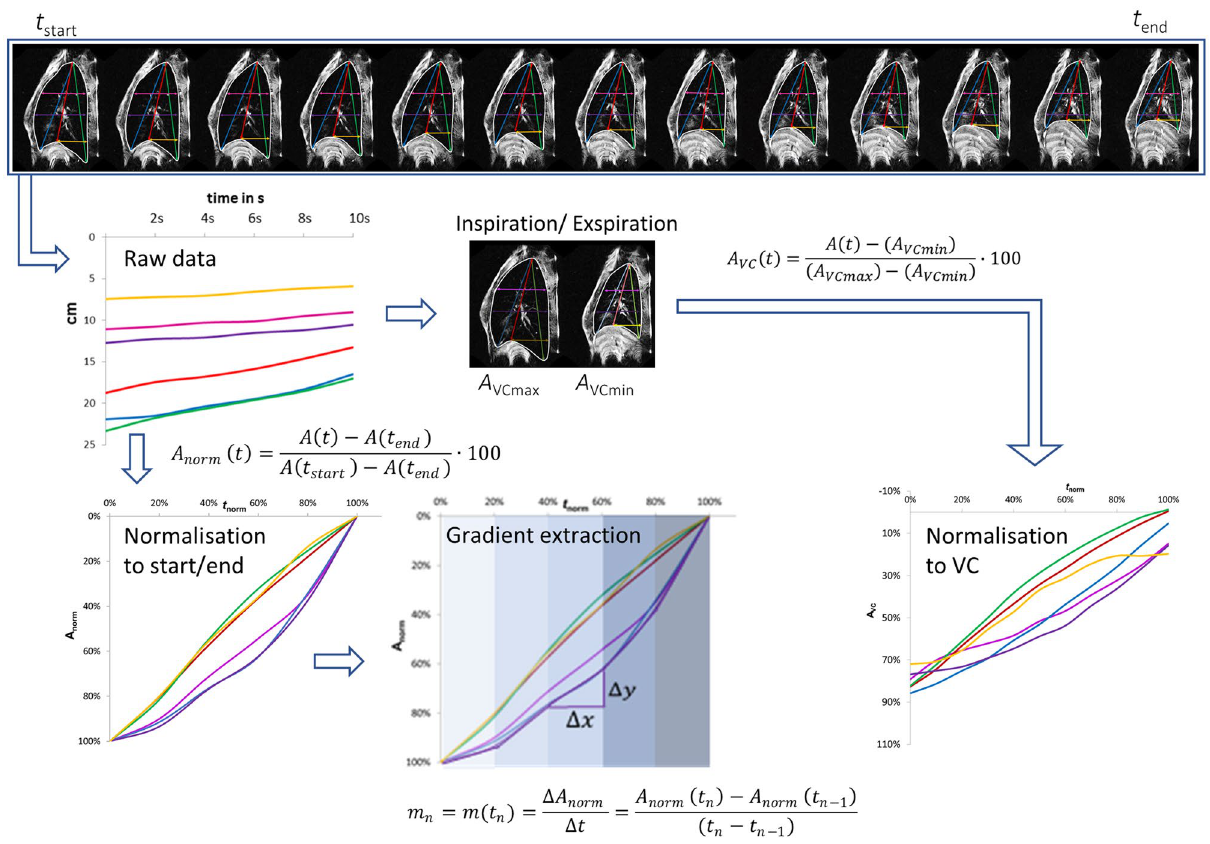
Figure 3. Flow-chart of data normalisation and analysis. Raw data of 6 distance parameters were measured in each acquired image sequence. For inter-individual comparison. The timeline has been rescaled: The start of phonation was set to 0% the end point to 100%. Additionally, the distance parameters were normalized to start and end point of phonation (left part) as well as to maximum inspiration and expiration (right part). VC stands for vital